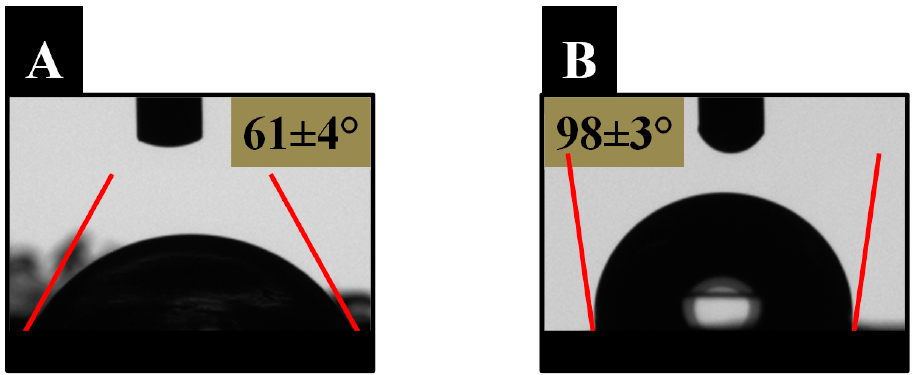
Figure 4. Water contact angle of P(BMA-HEA) free nanopillars of the copolymer synthesized in confinement ( A ) and films of the copolymer synthesized in bulk ( B ).